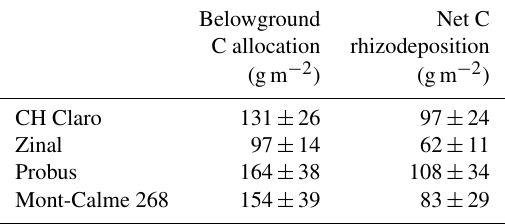
Table 2. Average belowground carbon allocation (net rhizodeposi- tion and root biomass combined) and net carbon rhizodeposition by the different wheat cultivars, calculated down to a depth of 0.45m (variation is reported as the standard error, n = 3). No statistically significant differences in belowground C allocation or net C rhi- zodeposition between any of the cultivars were